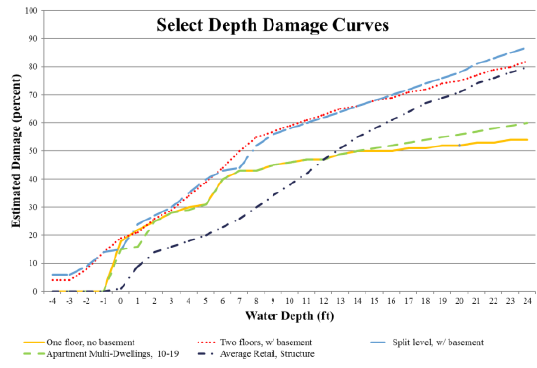
Figure 5. Examples of Depth Damage curves (FEMA,